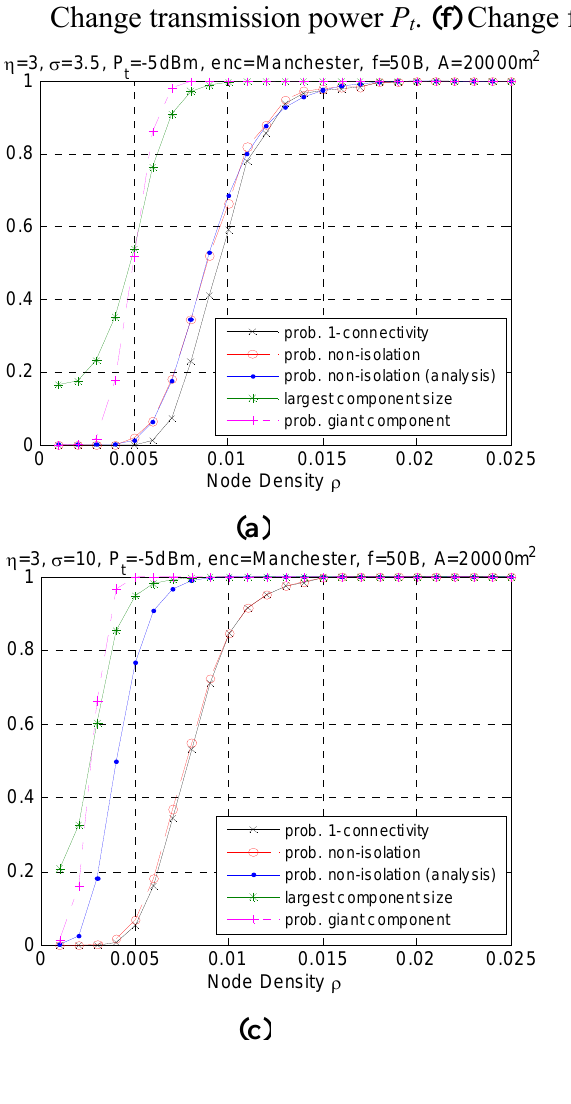
Figure 5. Simulated results for different settings. (a) Benchmark. (b) Change path loss exponent η . (c) Changing shadowing variance σ . (d) Change encoding method E .